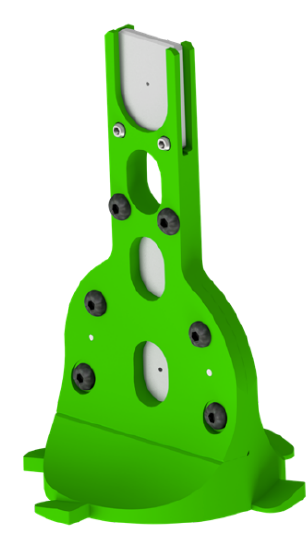
Fig. 2. Sketch of the NUMEN target